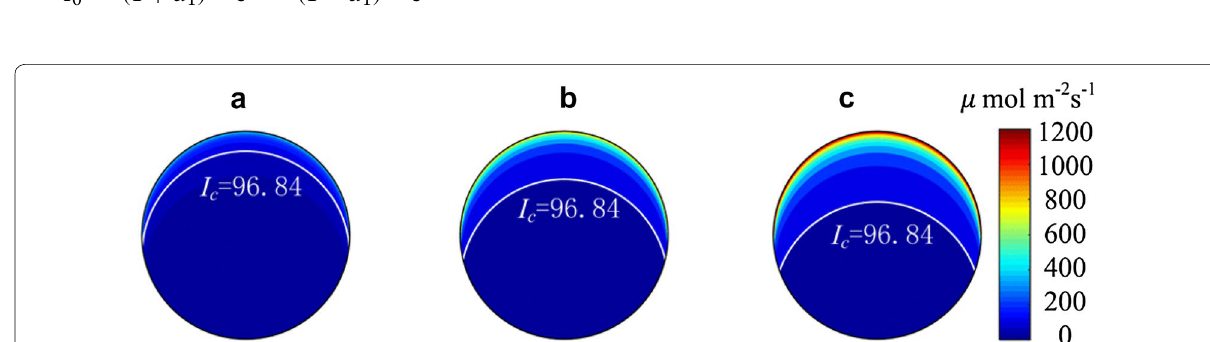
Fig. 2 Light profile for the incident light intensity of a 375 μmol m − 2 s − 1 , b 800 μmol m − 2 s − 1 and c 1200 μmol m − 2 s −